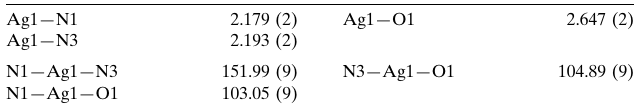
Selected geometric parameters (A˚ , (cid:2) ).